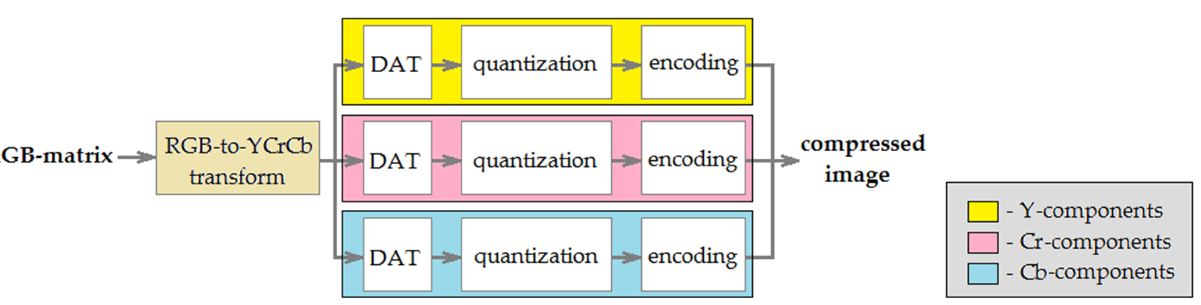
Figure 1. Discrete atomic compression of full-color digital images.